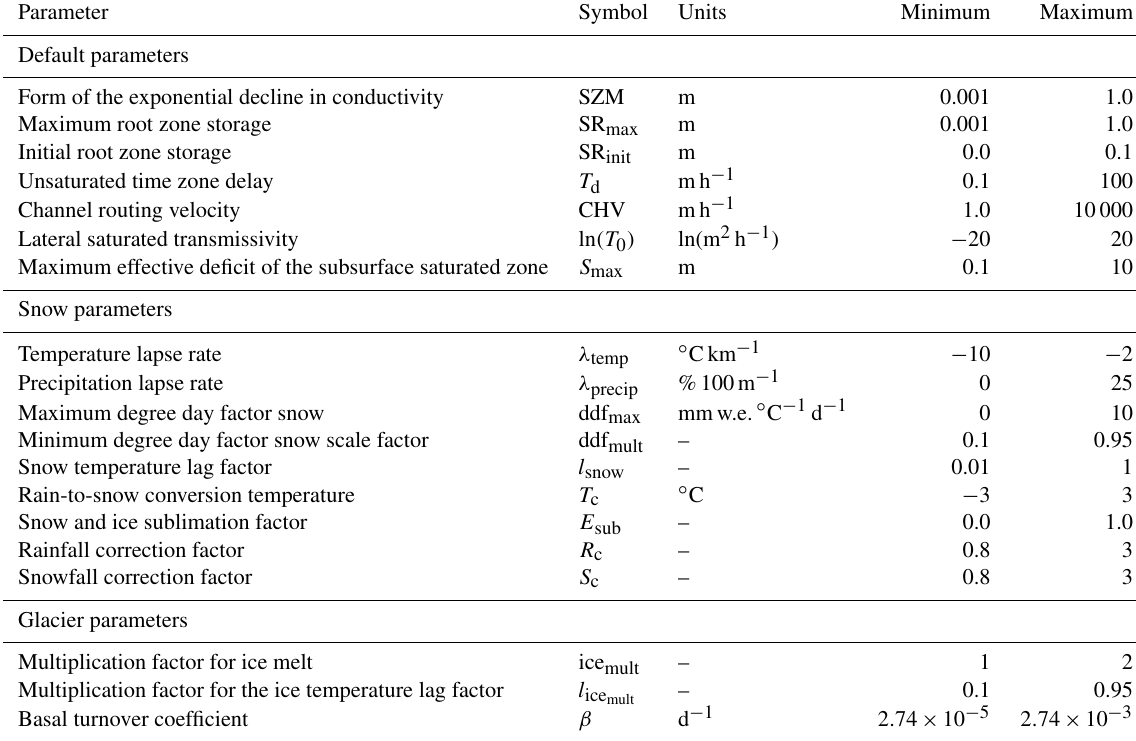
Table 3. List of parameters and ranges. Default parameters are described in detail in Coxon et al. (2019). The glacier and snow parameters have been added to the model for this